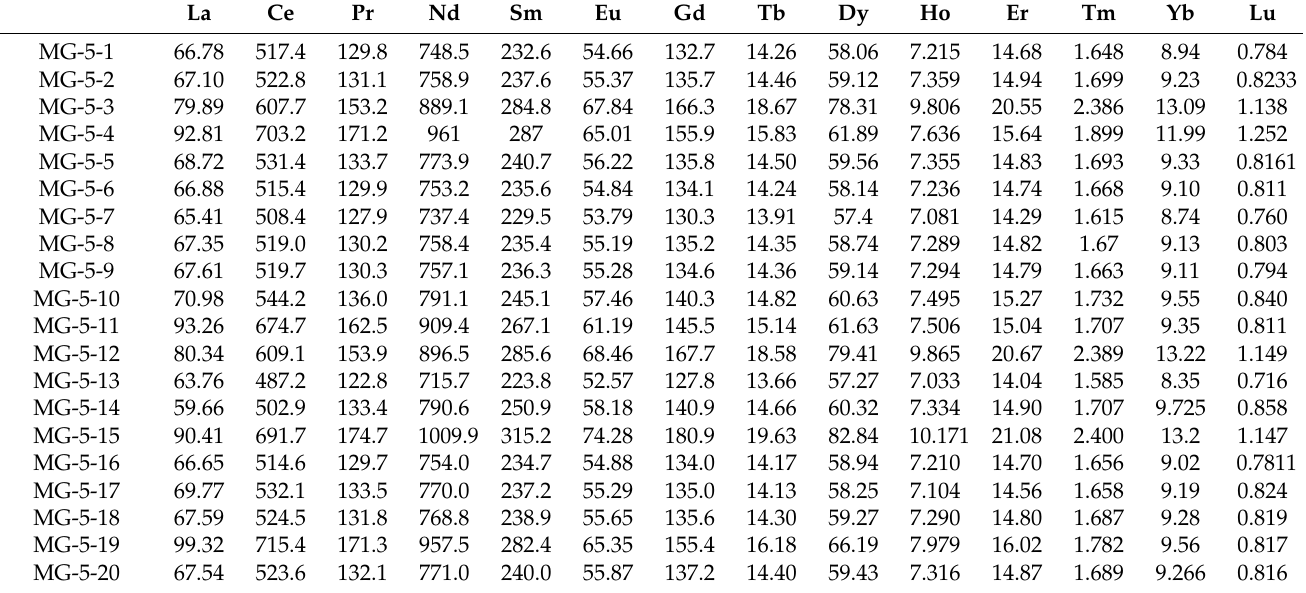
Table 2. Rare earth element content (ppm) of MG-5.